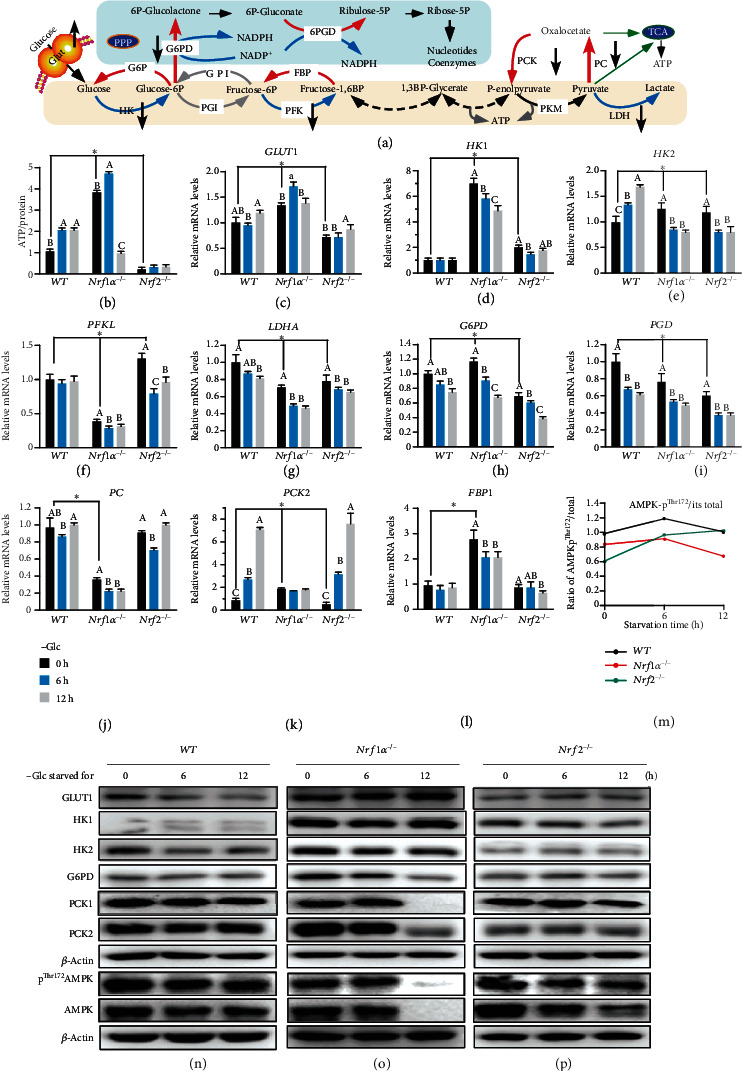
Deterioration of altered glucose metabolism and energy demands by glucose deprivation of Nrf1α−/− cells. (a) A schematic diagram to give a concise explanation of glycosis, gluconeogenesis, and pentose phosphate pathways (PPP). The key rate-limiting enzymes are indicated, apart from TCA (citric acid cycle). In some words, phospho- is represented by a single P letter. (b) Distinct ATP levels of WT, Nrf1α−/−, and Nrf2−/− cells were determined after glucose deprivation for 0-12 h. (c–l) Altered mRNA expression levels of key metabolic genes: (i) (c) GLUT1 (glucose transporter 1), (d) HK1 (hexokinase 1), (e) HK2, (f) PFKL (phosphofructokinase liver type), and (g) LDHA (lactate dehydrogenase A) involved in the glycolysis pathway; (ii) (h) G6PD (glucose-6-phosphate dehydrogenase) and (i) PGD (phosphogluconate dehydrogenase) as rate-limiting enzymes in the PPP; (iii) (j) PC (pyruvate carboxylase), (k) PCK2 (phosphoenolpyruvate carboxykinase 2), and (l) FBP1 (fructose bisphosphatase 1) responsible for the gluconeogenesis pathway, were analyzed by RT-qPCR analysis of WT, Nrf1α−/−, and Nrf2−/− cells that had been starved, or not starved, in the glucose-free media for 0-12 h. Then, the asterisk “∗” only represents a significant change in WT, Nrf1α−/−, and Nrf2−/− cell lines in the glucose-free culture for 0 h (P < 0.05), while the letters A, B, and C represent significant changes in the same cell line without glucose cultured for 0, 6, and 12 h (P < 0.05). (m) Phospho-AMPKThr172/AMPK ratios were calculated by the intensity of their immunoblots in Nrf1/2+/+, Nrf1α−/−, and Nrf2−/− cells. (n–p) Changes in protein abundances of GLUT1, HK1, HK2, G6PD, PCK1, PCK2, AMPK, and its phospho-AMPKThr172 were determined by Western blotting of Nrf1/2+/+ (n), Nrf1α−/− (o), and Nrf2−/− (p) cells, after having been glucose-starved, or not, for 0-12 h.